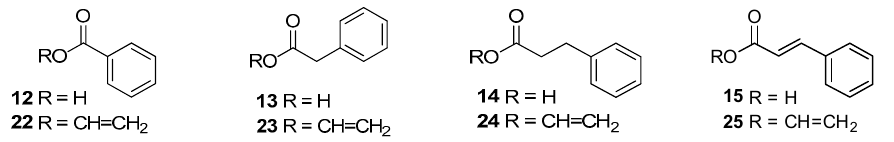
Figure 2. Aromatic acids 12 – 15 and their activated forms 22 – 25 used in the enzymatic approach [22,23]. IQ derivatives 2 , 4 , and 5 were prepared previously [11] using Chirazyme L-2 or Amano-PS as catalysts and vinyl esters of respective aromatic acids were used as acyl donors. However, formation of these products was confirmed only by 13 C NMR and MS, but 1 H NMR was missing. NMR and MS data are missing completely in the work of Nakajima et al. [18], who claimed the preparation of IQ cinnamate ( 5 ) with an enzymatic system from cultured cells of Ipomoea batatas . In contrast, we present here full structural data of all these esters (see Section 3.4.1 and Tables S1–S3 and Figures S1–S8 in the Supplementary Materials).